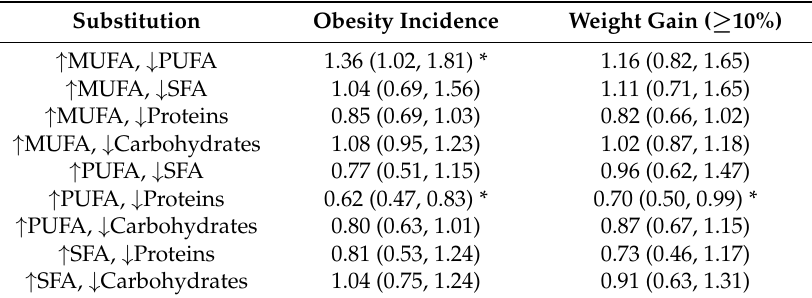
Table 3. Estimated odds ratios (95% confidence interval) 1 for incidence of obesity and substantial weight gain ( ≥ 10%) after isocaloric substitution of 5% energy from MUFA, PUFA, and SFA, proteins, and carbohydrates.